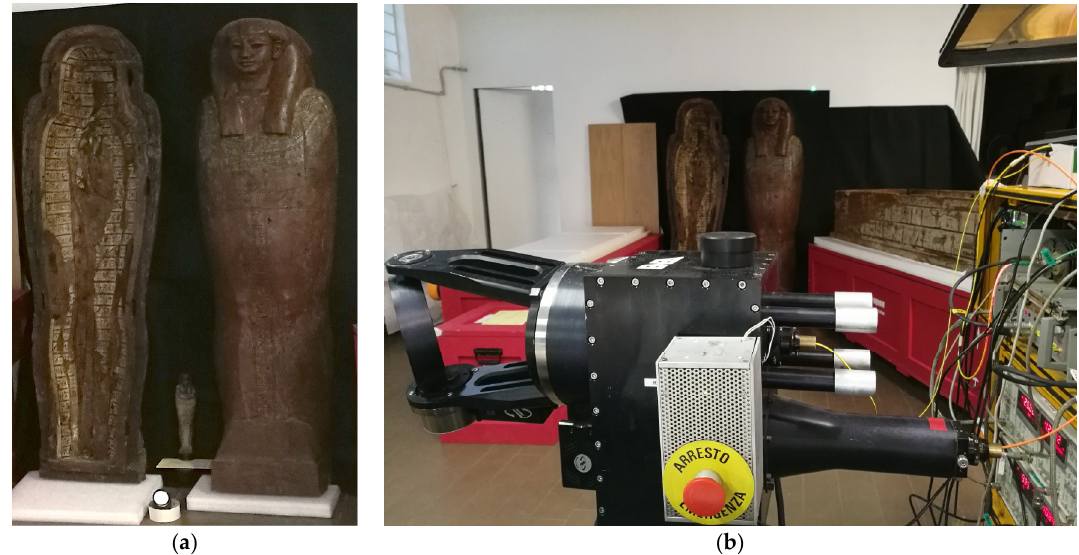
Figure 7. Digitalization of Egyptian wooden sarcophagus of Peftjauyauyaset: ( a ) the artefact in one of the three positions during the scan. The decorations are clearly evident both internally and externally, where also incisions characterize the artefact; ( b ) acquisition conditions with the RGB-ITR laser scanner. (Photo: S. Ceccarelli).